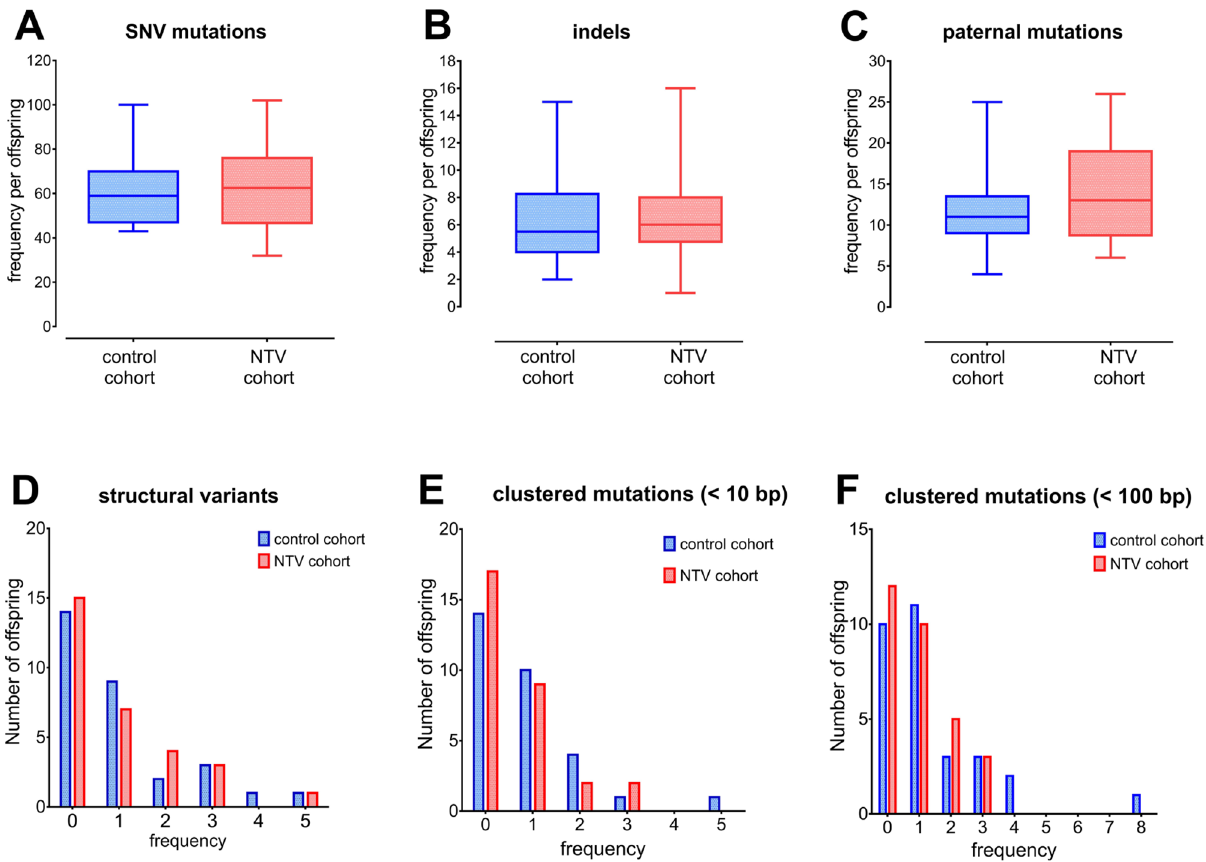
Figure 1. The frequency of de novo mutations per offspring in controls and NTV families. ( A ) SNV mutations; ( B ) indels; ( C ) paternal mutations; ( D ) structural variants; ( E ) clustered mutations (< 10 bp); ( F ) clustered mutations (< 100 bp). 95% confidence intervals are shown.